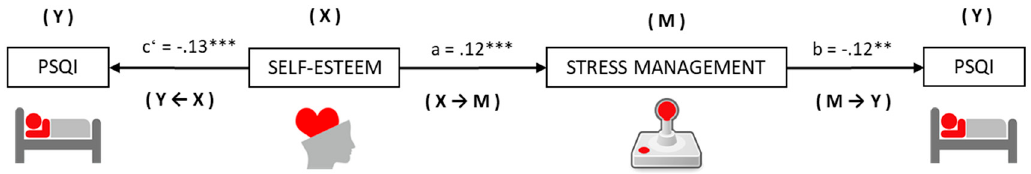
Figure 2. Mediation model of stress management in the relationship between self-esteem and sleep